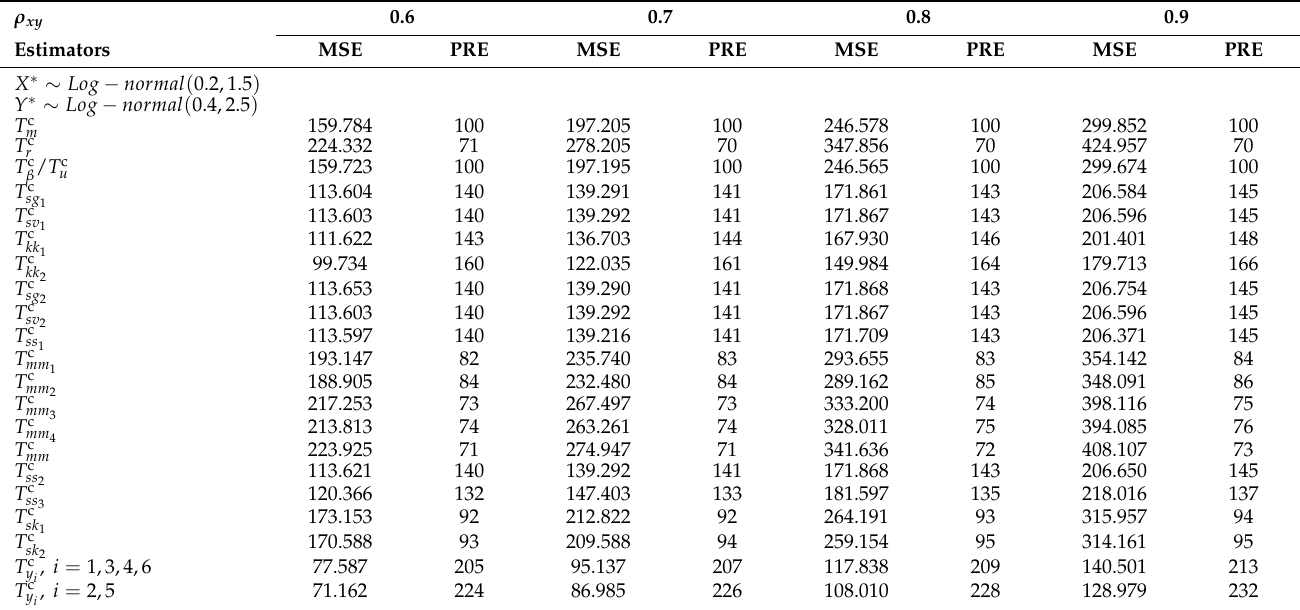
Table 6. MSE and PRE of combined estimators utilizing hypothetically drawn Log-normal popula-